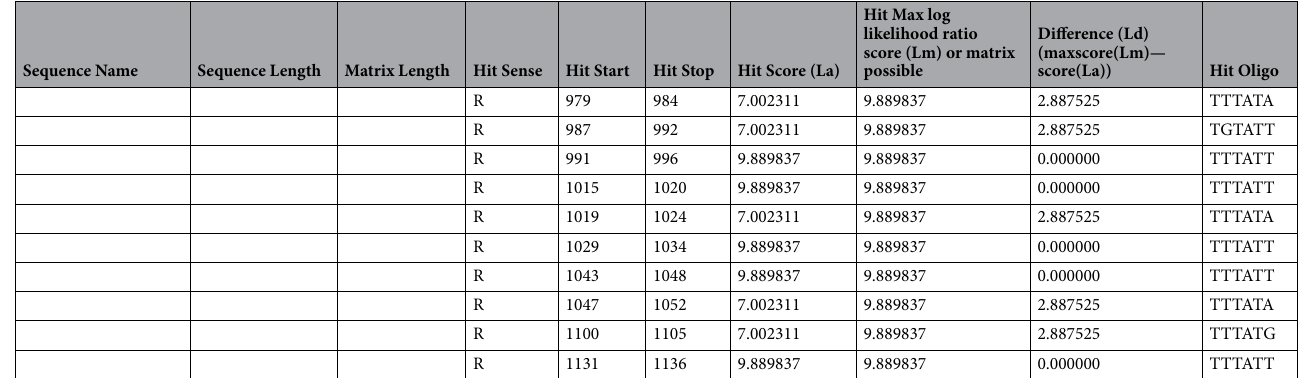
Table 1. Results of the poly adenylation site motif search. AIModules allows a search for polyadenylation site motifs. Generally, with AIModules one may search for functional RNA sites as well. The matrix was generated from twelve consensus sequences. Matches on the antisense strand (R) apply only to DNA.